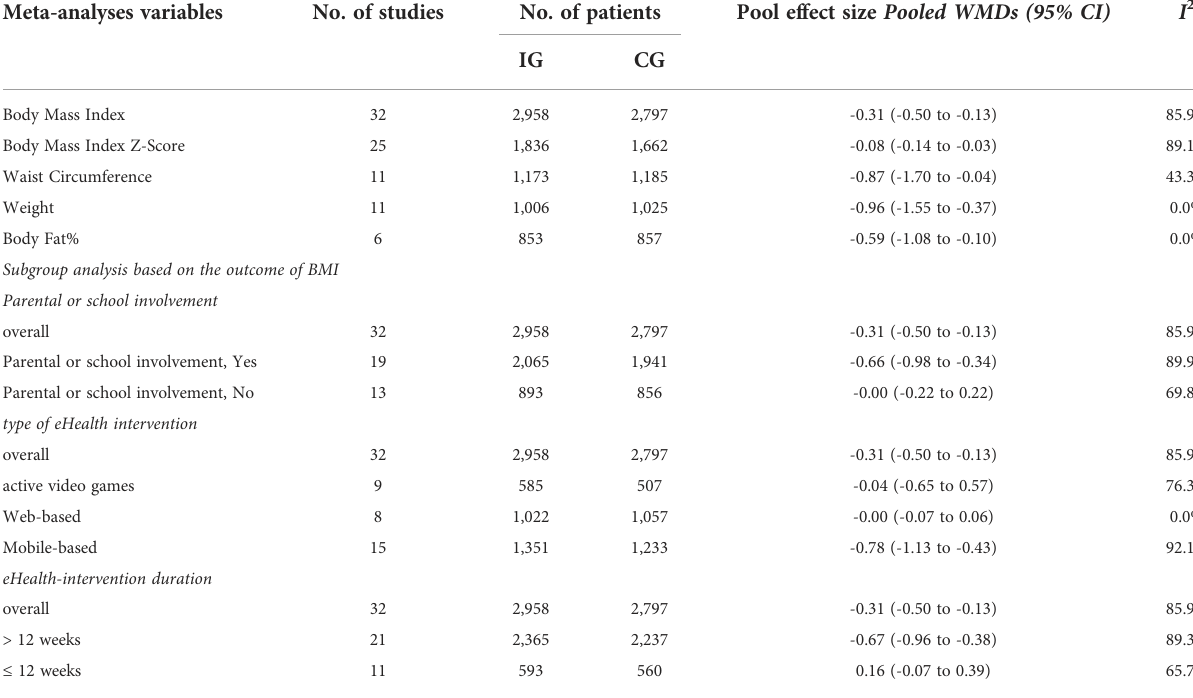
TABLE 2 Results of the various outcomes and subgroup